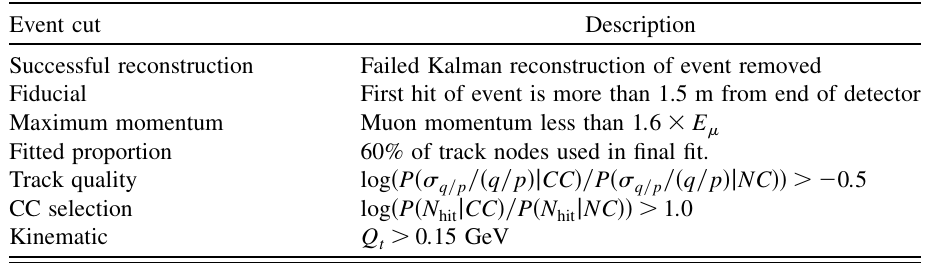
TABLE II. Description of cuts used in the selection of good events from the simulation. Event cut Description Successful reconstruction Failed Kalman reconstruction of event removed Fiducial First hit of event is more than 1.5 m from end of detector Maximum momentum Muon momentum less than 1 : 6 (cid:2) E (cid:4) Fitted proportion 60% of track nodes used in final